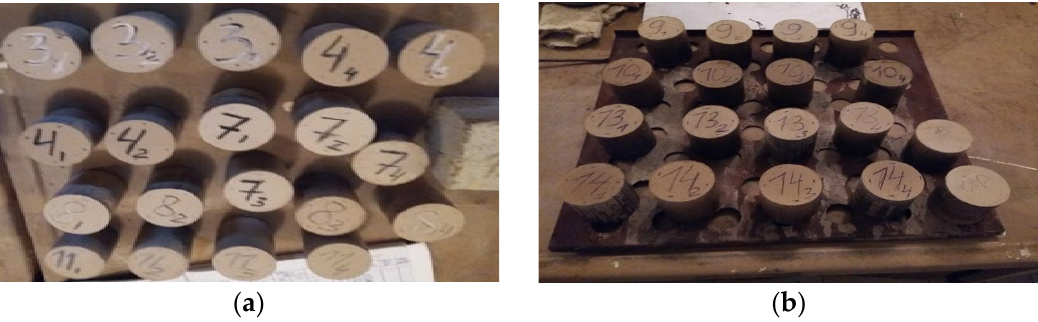
Figure 6. Samples after drying. ( a ) at 20 to 60 °C; ( b ) at 60–105 °C.